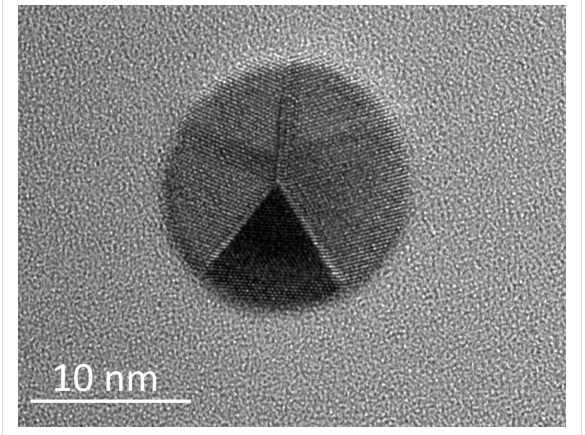
Figure 3: Au NP annealed at 800 °C with well-pronounced five-fold twinned inner structure.